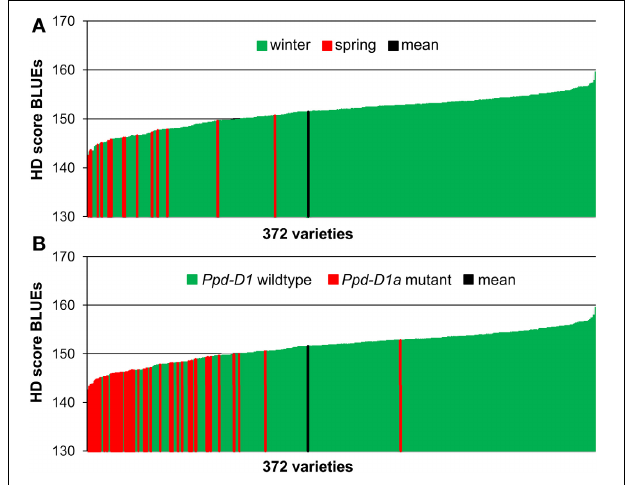
FIGURE 1 | Phenotypic distribution of HD score BLUEs in 372 wheat varieties. The BLUEs of the HD score were calculated across eight environments. A low score indicates earlier heading date. HD sore BLUEs were arranged according to the growth habit (A) or to the distribution of the Ppd - D1 wildtype or Ppd - D1a mutant gene (B)